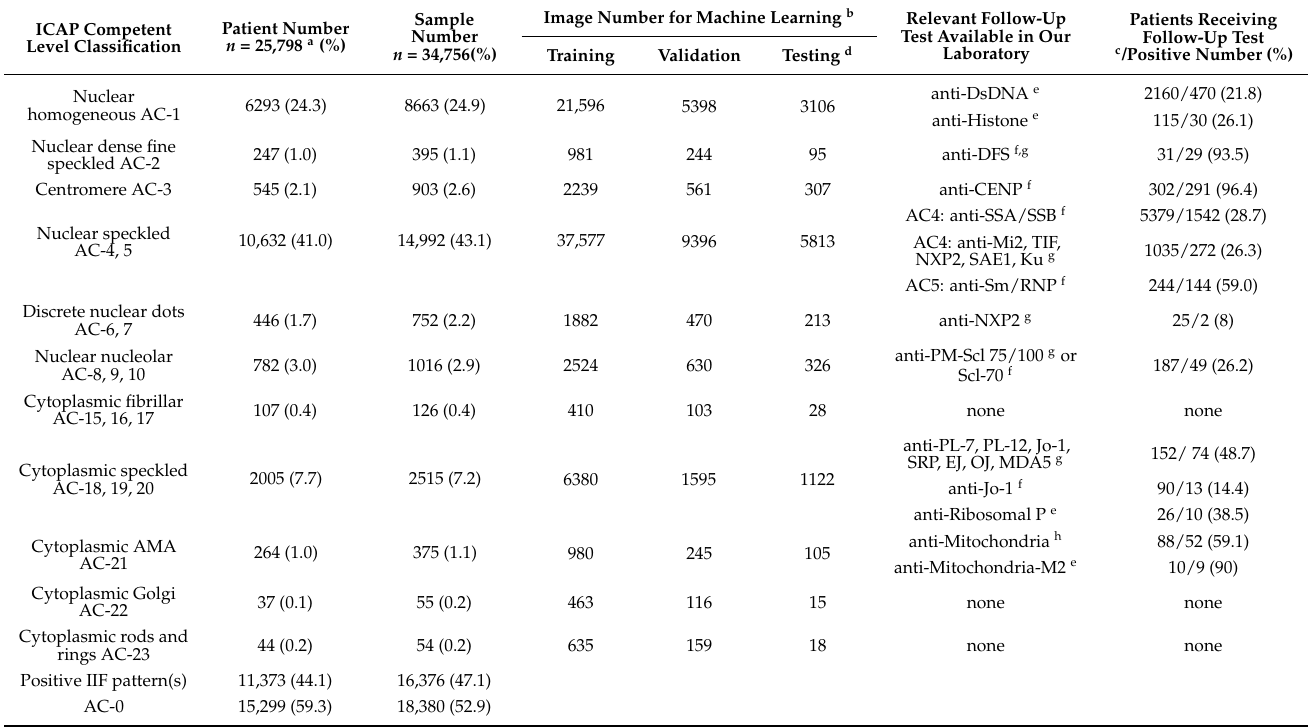
Table 1. ICAP classification distribution, image number for machine learning, analysis of relevant follow-up test in the study